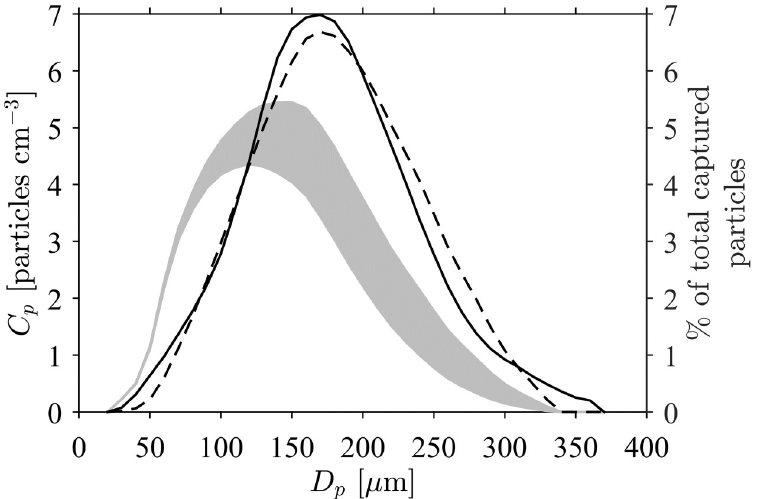
Fig 5. The discrepancy between size distributions of particles in suspension (gray band) and those captured by the tube feet of a brittle star (—) [5]. Settling during the experiment reduced both the concentration and average size of particles in suspension; the upper edge of the gray band represents the initial particle concentration distribution (on the left-hand axis) within 10 μ m bins, the lower edge the final distribution. Lines indicate (on the right-hand axis) the size distributions of captured particles: (i) observed experimentally in the bolus of the brittle star (—) and (ii) predicted by the numerical model (- - -). The greater peak particle diameter in the distribution of captured particles indicates an increasing contact rate with particle